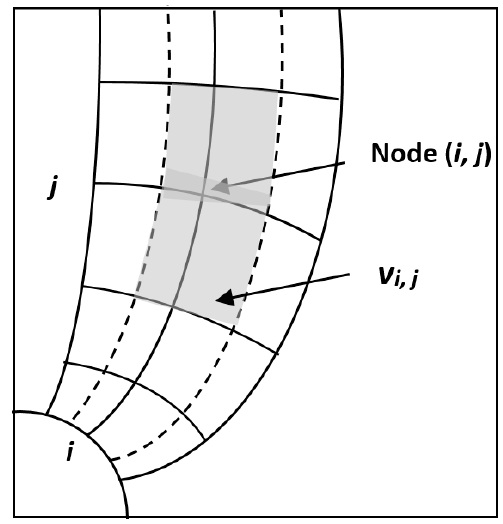
Figure 9. The volume around node ( i, j ) with the i th flux-tube.